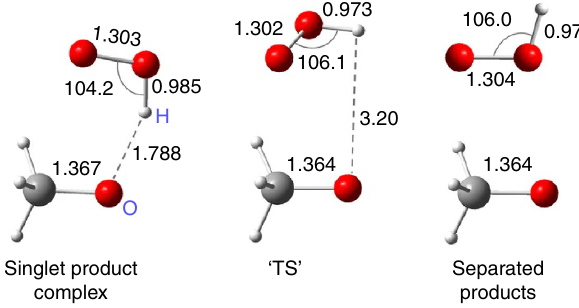
Figure 2 | Dissociation of product complex and the variational transition state. Bond lengths are in angstrom. Angles are in